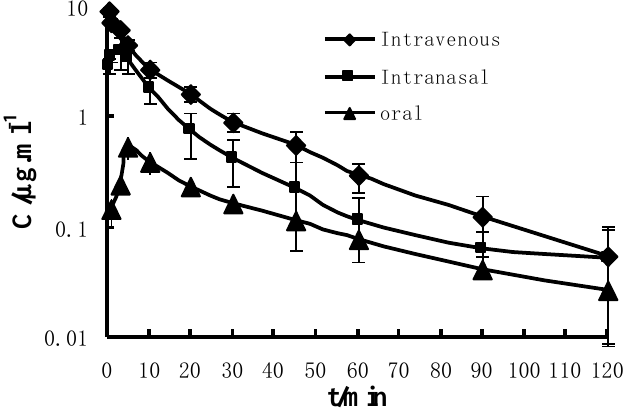
Figure 1. Concentration of paeonol in plasma (n = 6, mean ± S.D.) following a single i.v. ( ◆ ), i.n. (■), or i.g. (▲) administration; calculated dosage of 4 mg·kg -1 of paeonol in rats.